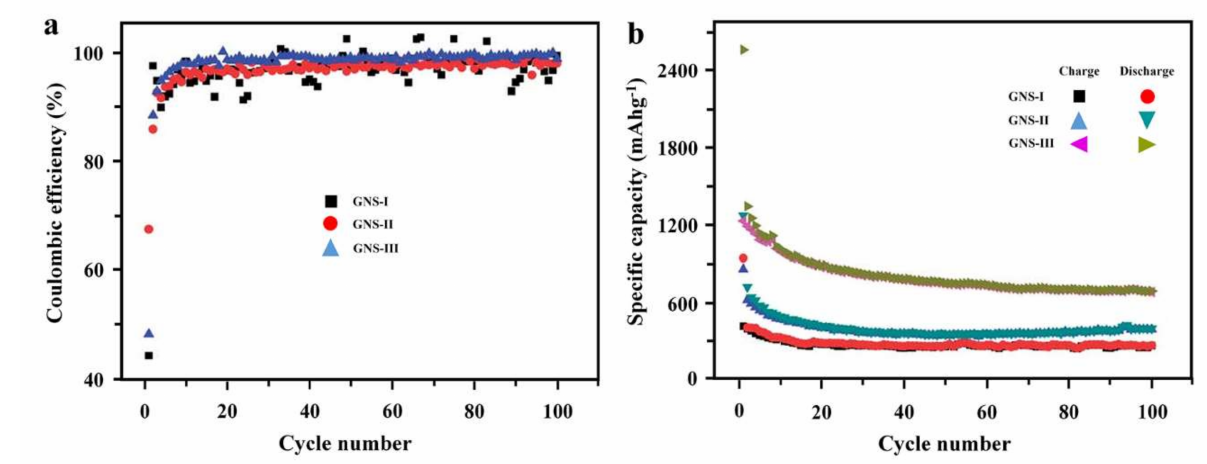
Figure 10. Cycling stability of graphene nanosheets synthesized by varying the conditions as anodes tested in the half cell; ( a ) Coulombic efficiency against cycle numbers of various GNSs, ( b ) cycling stability of various GNSs at 100 mA g − 1 . Adapted and reproduced with permission from Ref. [35]. Copyright 2013 Royal Society of